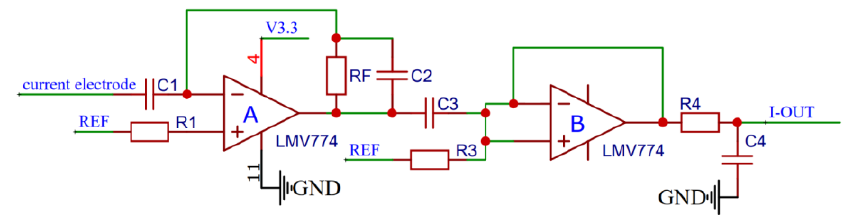
Figure 14. Schematic diagram of a current signal conditioning circuit.